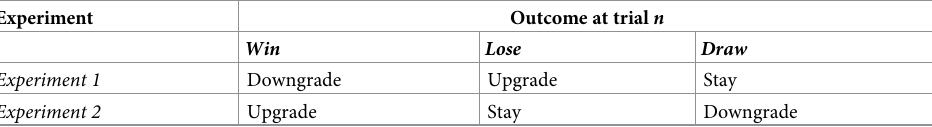
Table 1. Optimal strategy for trial n+1 as a function of outcome at trial n against exploitable opponents in Experi- ments 1 and